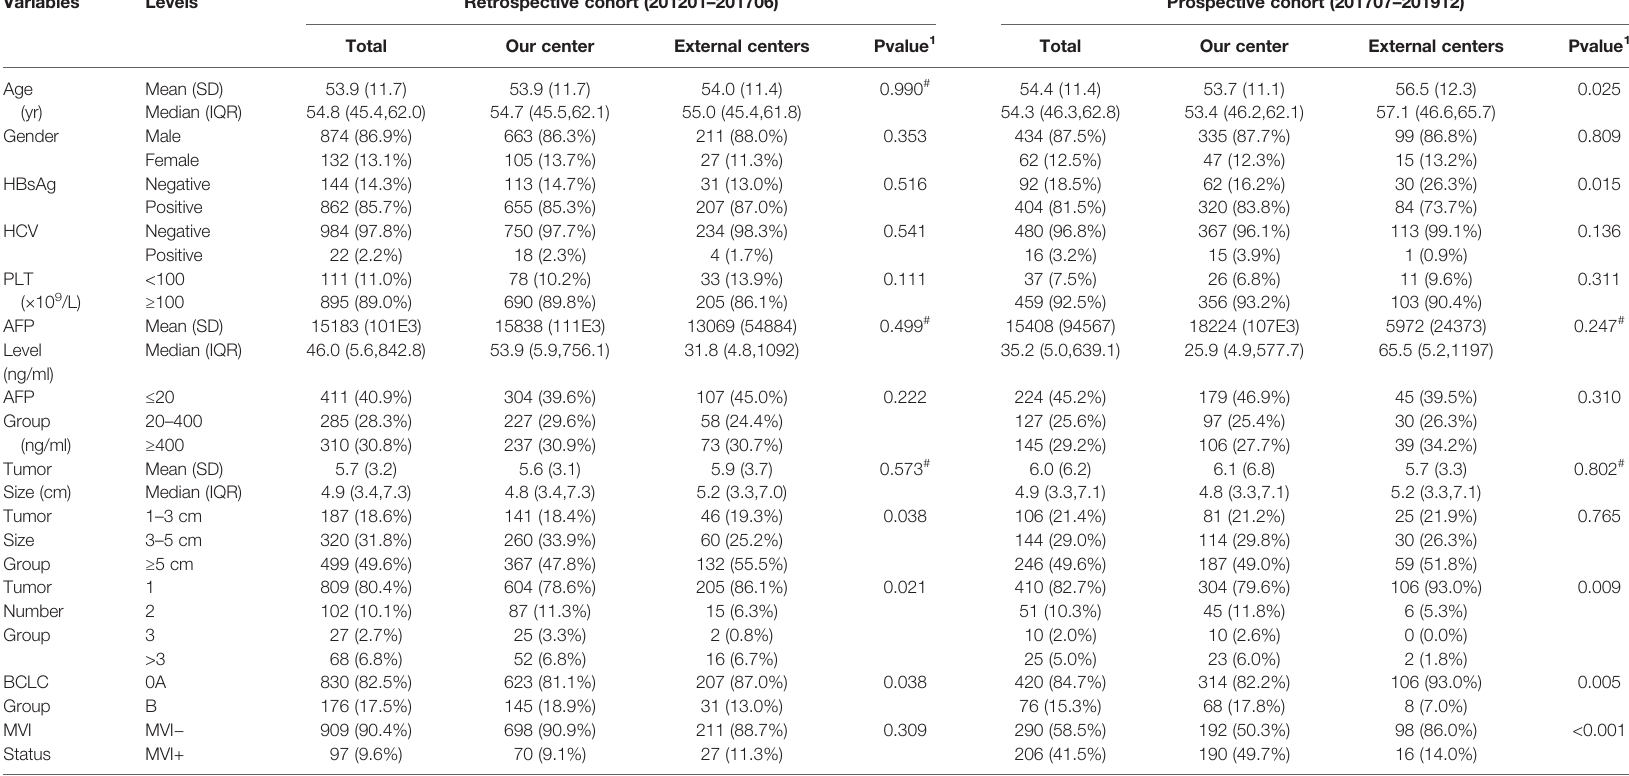
TABLE 1 | Baseline characters for all patients in our center and external